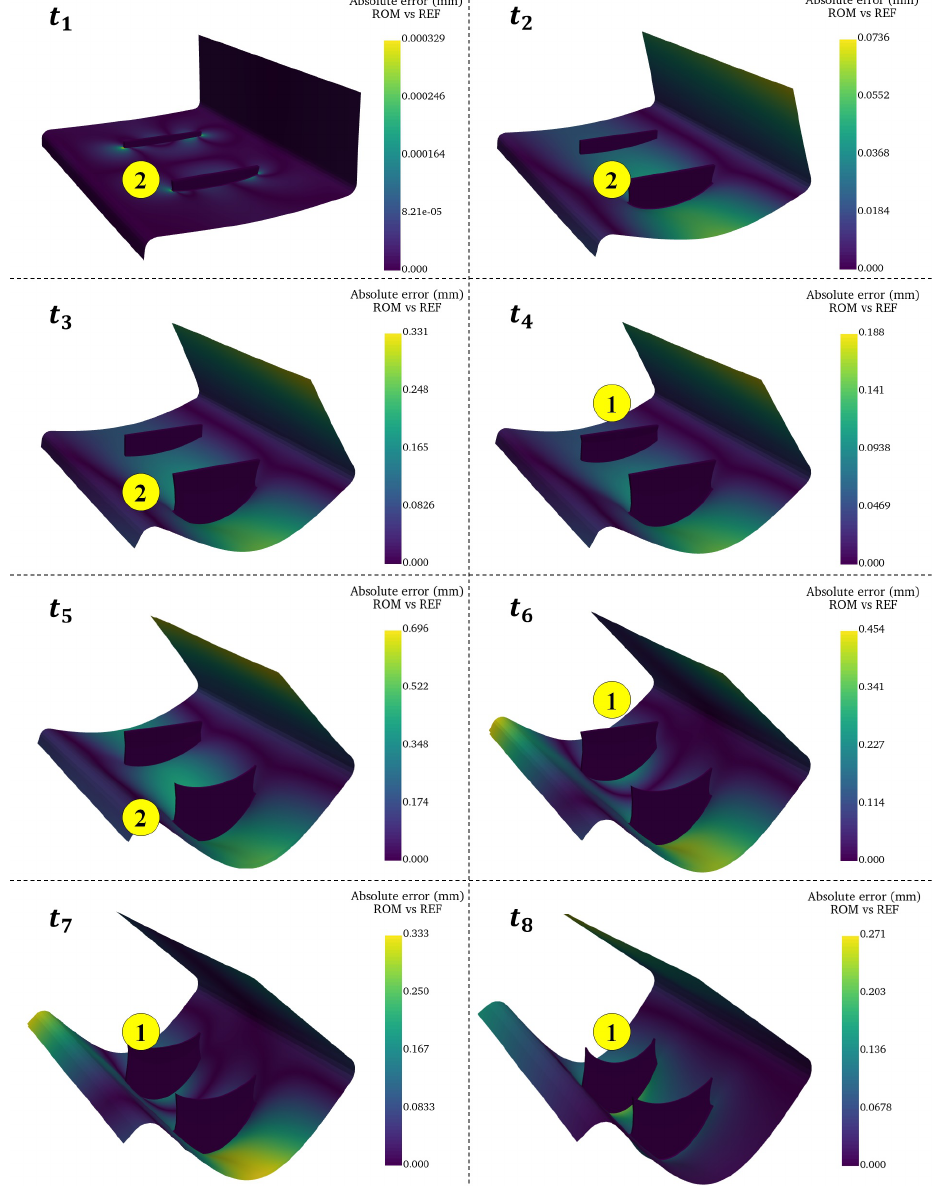
Figure 18. DMD approximation of sequence { 2,2,2,1,2,1,1,1 } with its reference (displacements × 10 for